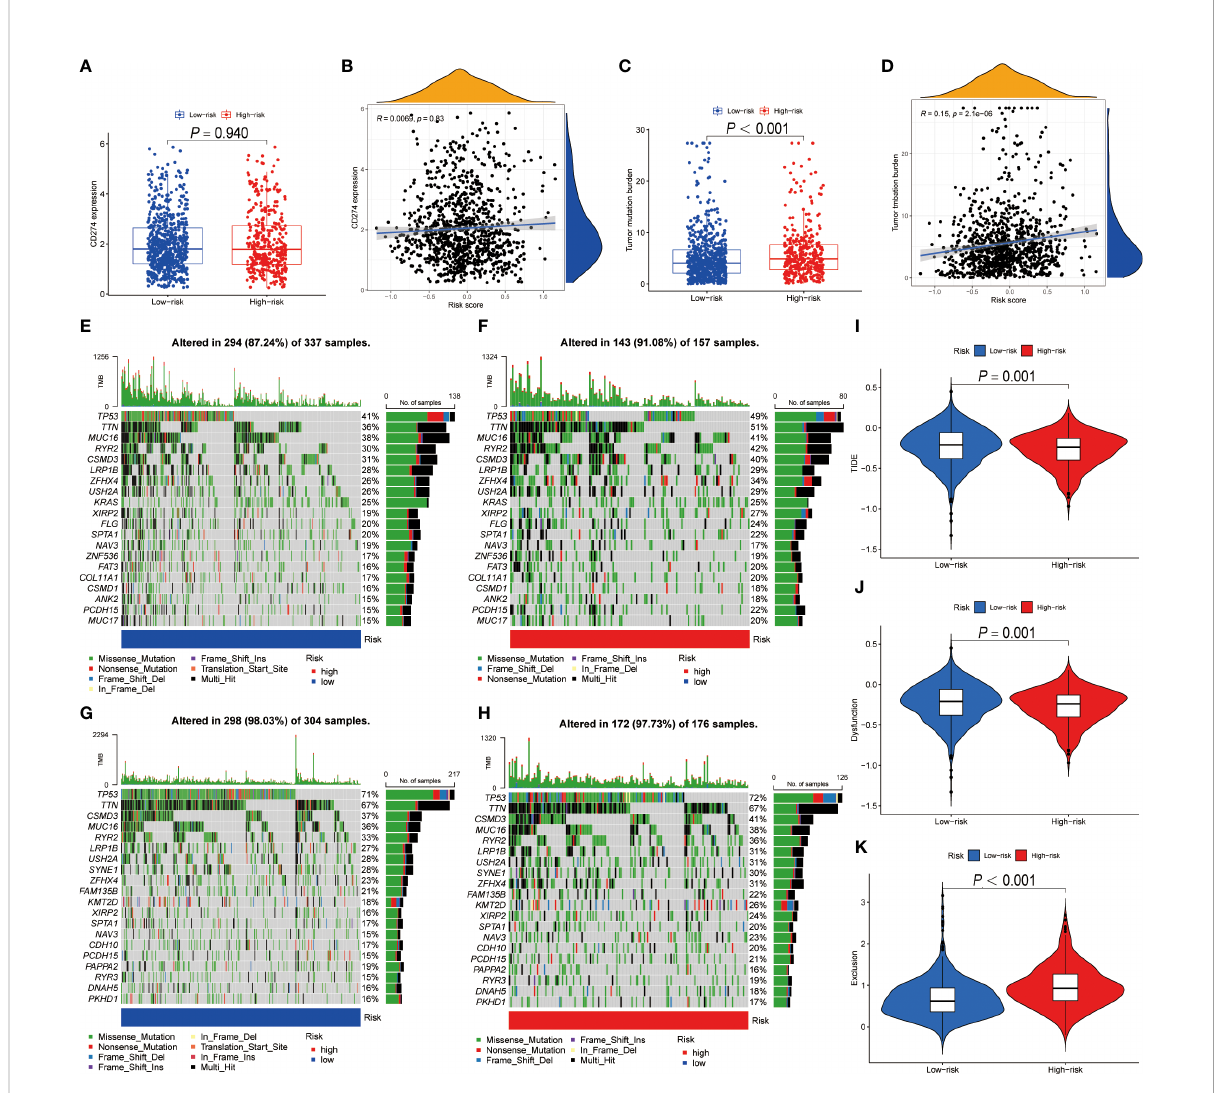
FIGURE 8 The predictive ability of BRGPs signature in NSCLC patients with immunotherapy. (A – D) . The box plot shows the PD-L1 mRNA (CD274) expression levels (A) and TMB scores (C) between high- and low-risk patients. The correlation analysis between the PD-L1 mRNA expression levels (C) and TMB scores (D) and the risk score in NSCLC patients, respectively. (E – H) The top 20 frequent mutation genes in low- (E) and high-risk (F) patients in TCGA-LUAD cohort. The top 20 frequent mutation genes in low- (G) and high-risk (H) patients in TCGA-LUSC